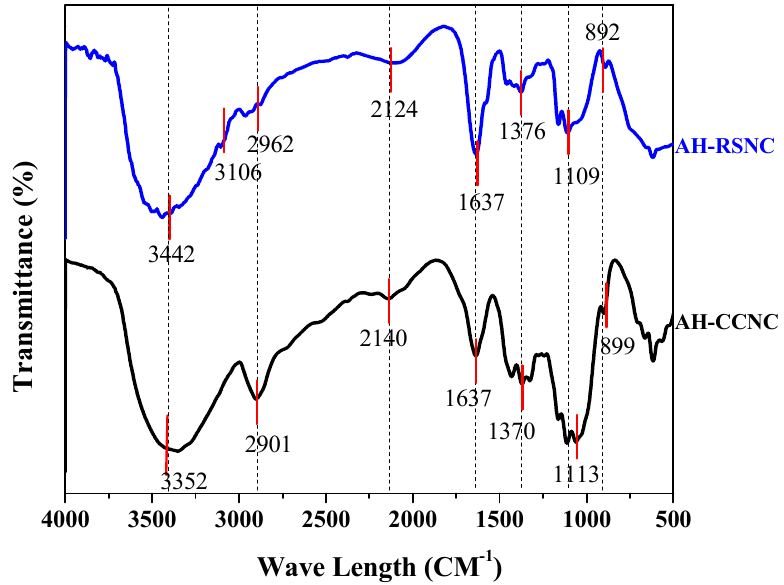
Figure 1. FT-IR of AH-CCNC and AH-RSNC.